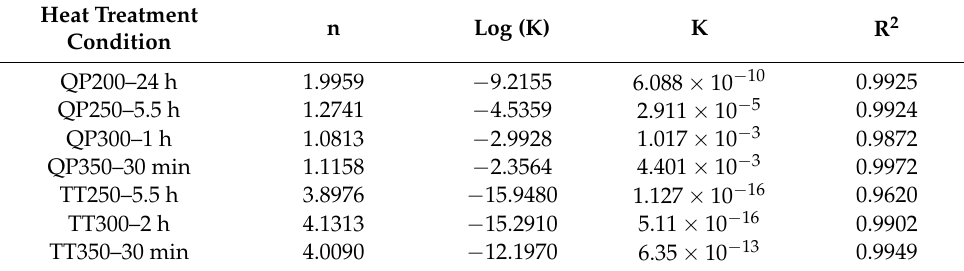
Table 3. Summary of the Avrami constants n and K for high-carbon steel .